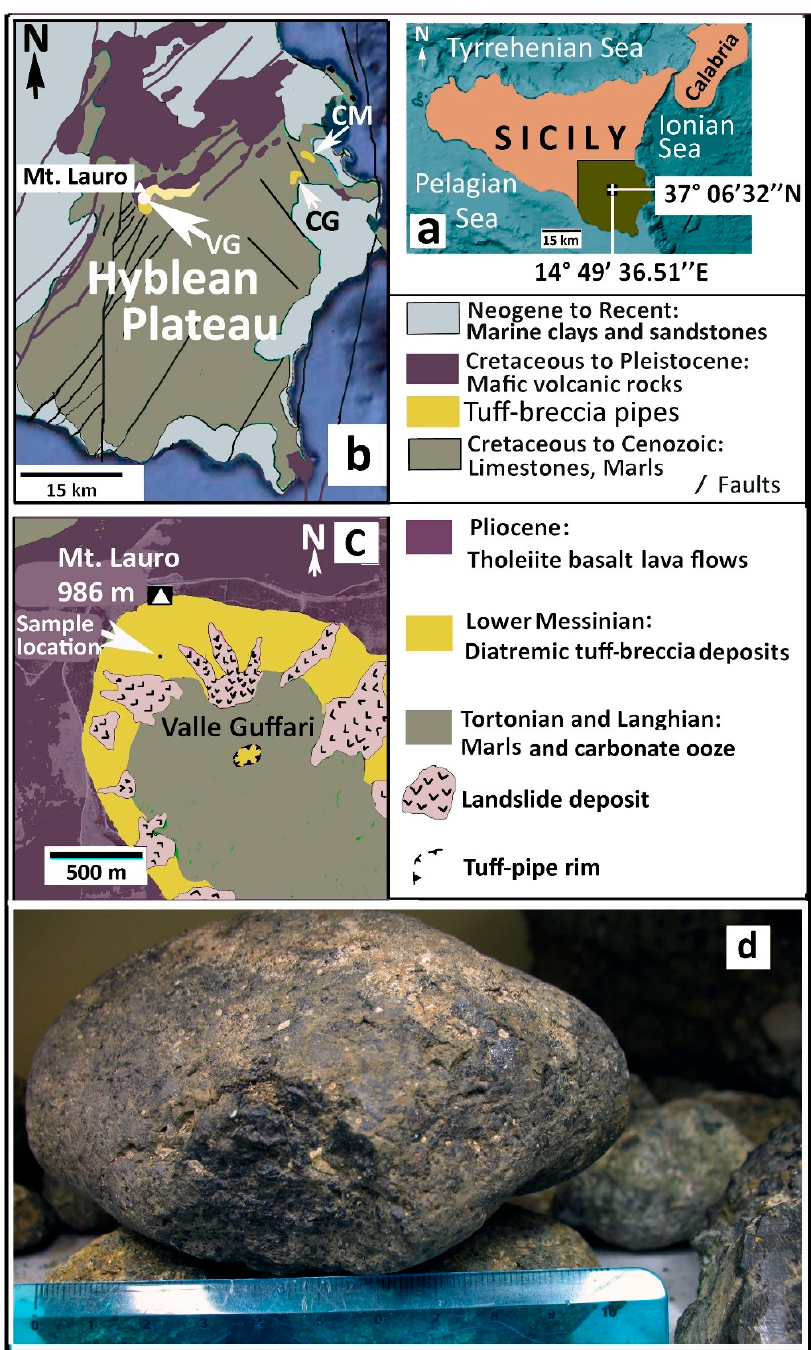
Figure 1. Location and geological setting of the xenolith-bearing diatremes and the sample. ( a ) General view of Sicily Island. The Hyblean Plateau area is highlighted by different color. Geographic coordinates indicate the sample location. ( b ) Geological sketch-map of the Hyblean Plateau. Arrows indicate the xenolith-bearing tuff-breccia deposits (CM = Cozzo Molino; CG = Costa Giardini; VG = Valle Guffari). The white circle indicates the sample location, in Valle Guffari. ( c ) Valle Guffari area with some detailed geological information. The arrow points to the sample location. The topography base was obtained from Google Earth. ( d ) Photograph of a garnet-pyroxenite xenolith from Valle Guffari, having almost the same size of the studied sample. The ruler is 10 cm in length.